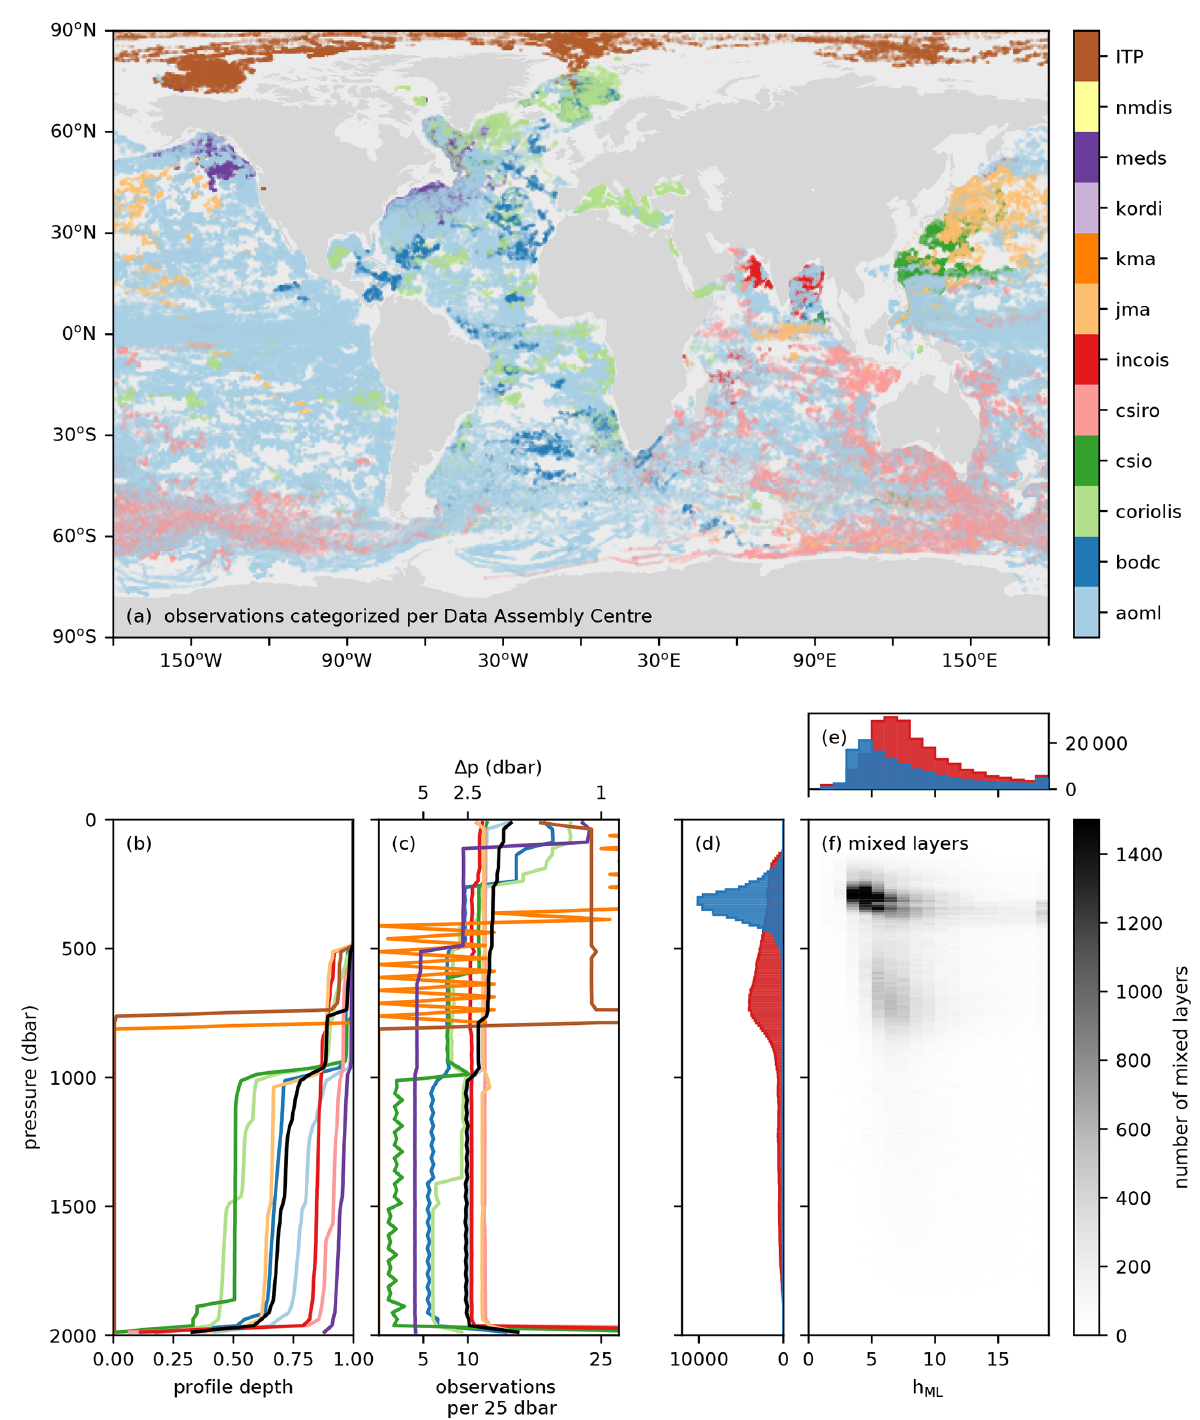
Figure 1. (a) Locations of observations categorized by Data Assembly Centres (DAC) when obtained by an Argo float. Profiles obtained with Ice-Tethered Profilers are indicated with ITP. (b) Cumulative fraction of profiles that reached a given pressure in 25dbar intervals from 0 to 2000dbar per DAC. (c) Average number of observations in 25dbar intervals from 0 to 2000dbar. (d) Distribution of detected mixed-layer pressures in the salt-finger (red histogram) or diffusive-convective (blue histogram) regime. (e) Number of detected mixed-layer height in the salt-finger (red histogram) or diffusive-convective (blue histogram) regime. (f) Distribution of detected mixed-layer heights in thermohaline staircases per pressure level. Panels (b, c) were obtained following Wong et al. (2020). Black lines indicate the averages in the total global dataset. More details on abbreviations of DAC can be found in Argo